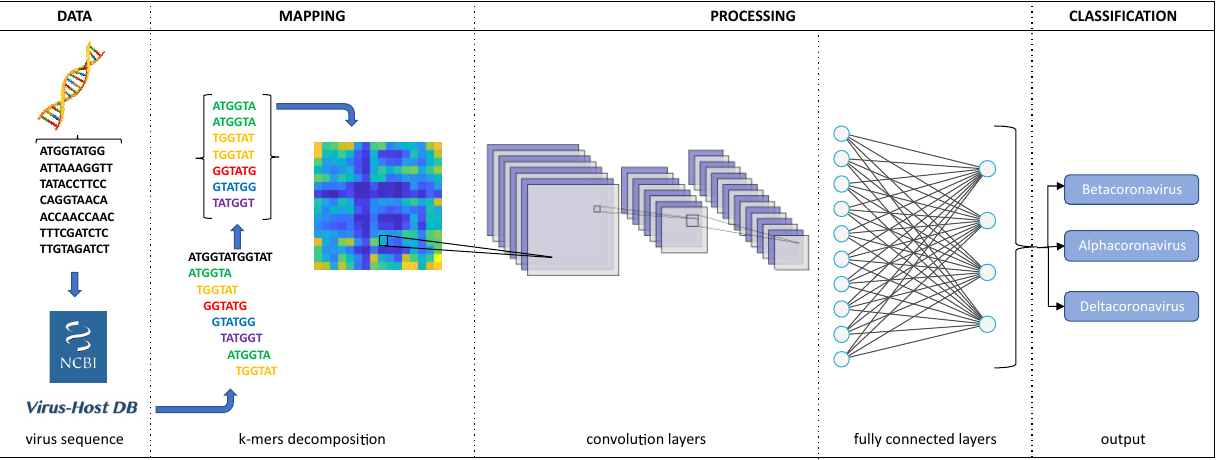
Figure 3. Overview of the proposed